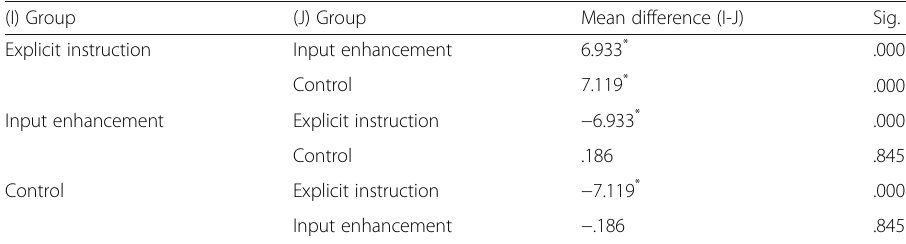
Table 6 Post Hoc tests using Tukey ’ s HSD test for the MKT (I)